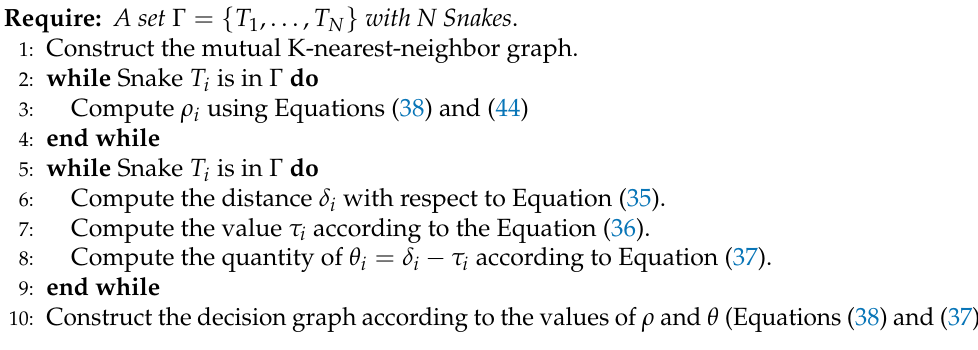
Algorithm 4 Density Peaks for Detecting the Number of Partitions in a Transportation